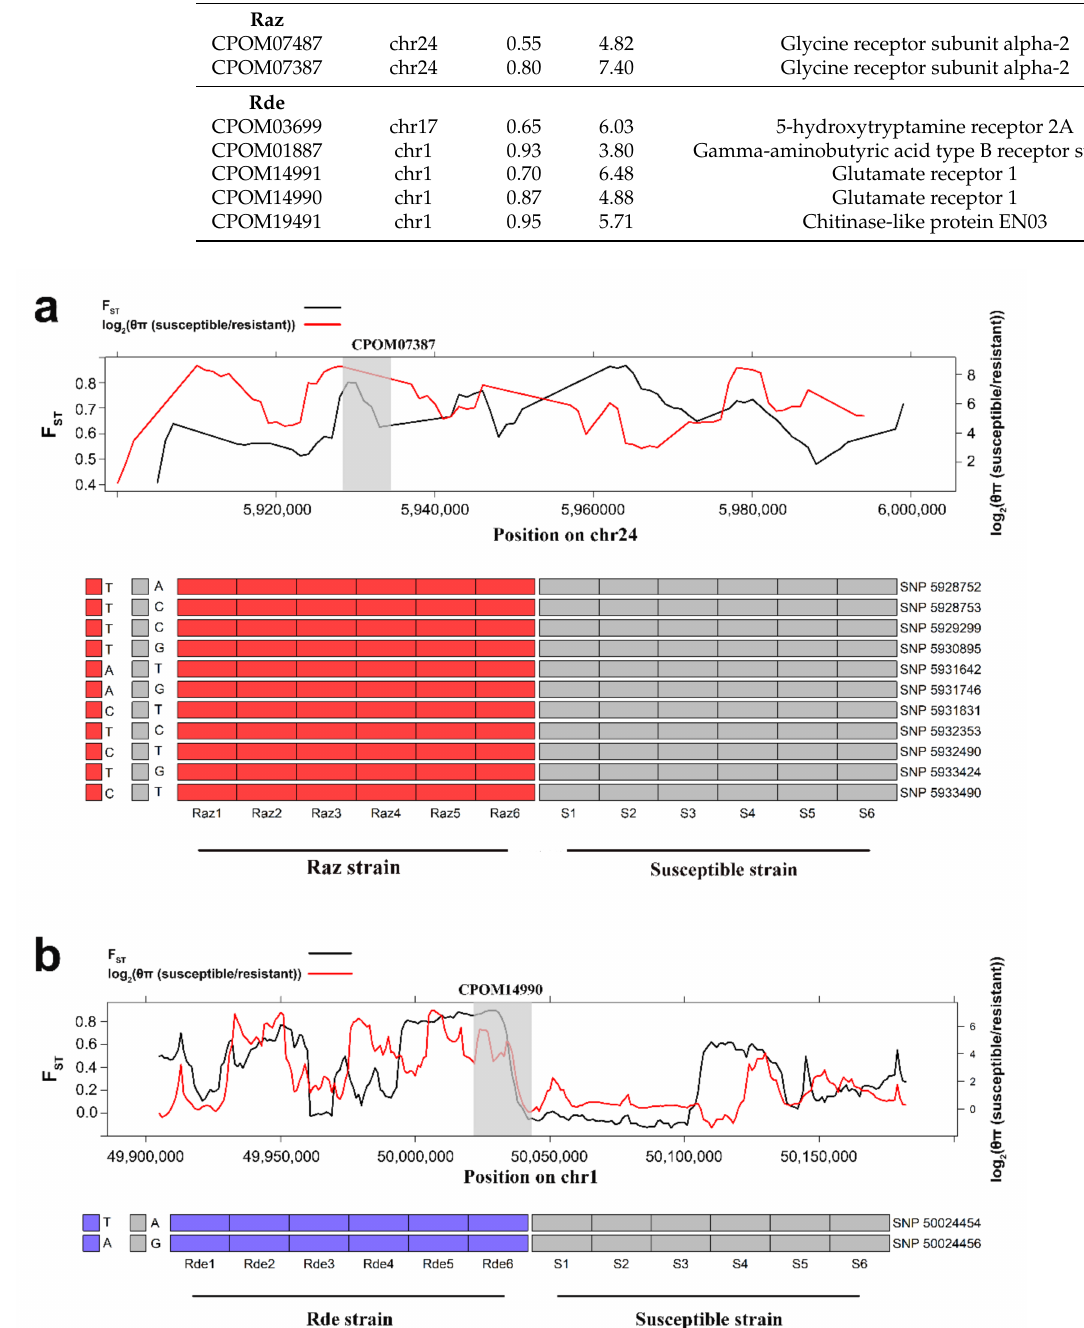
Figure 4. ( a ) Glycine receptor (geneID: CPOM07837) and ( b ) glutamate receptor (geneID: CPOM14990) showing different genetic signatures between resistant and susceptible C. pomonella strains. The upper parts of the figure show the F ST (red line) and θπ (susceptible/resistant) (black line) plot around glycine receptor and glutamate receptor. The x -axis represents the location in chromosomes (bp), and the gray area shows the location of glycine receptor and glutamate receptor . The lower part shows the 11 and 2 homozygous SNPs identified in the two resistant strains, which were absent in the susceptible strains. SNPs and INDELs were named according to their position on the chromosome. The red (or purple) grids represent the homozygous